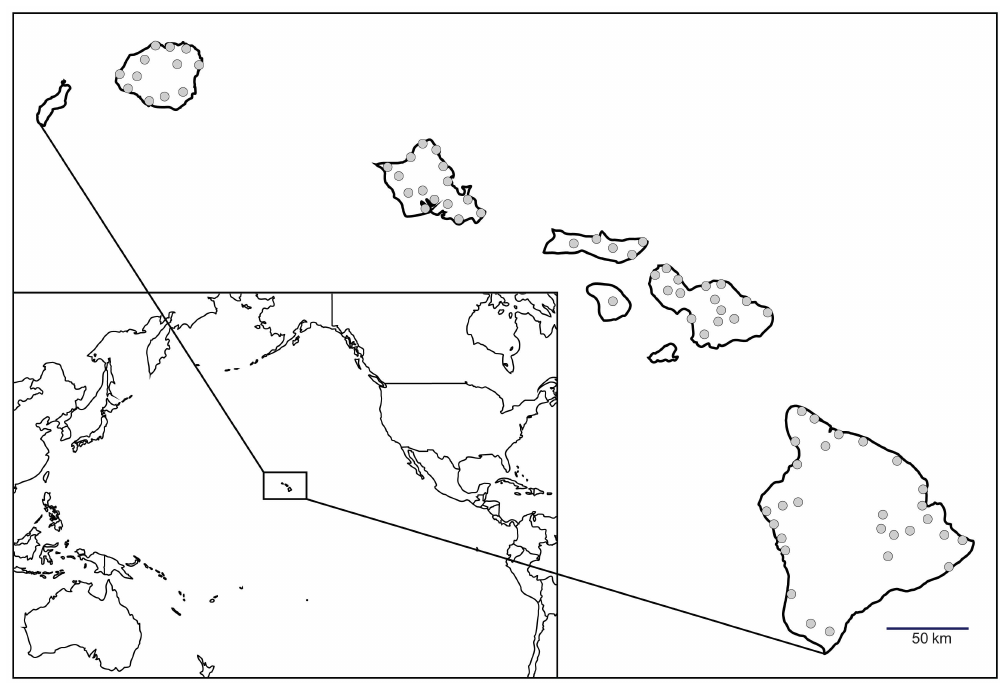
Figure 1. The extent of gastropod sampling throughout the main Hawaiian Islands. To show the broad geographic coverage, the map includes only sites 10 km or more away from each